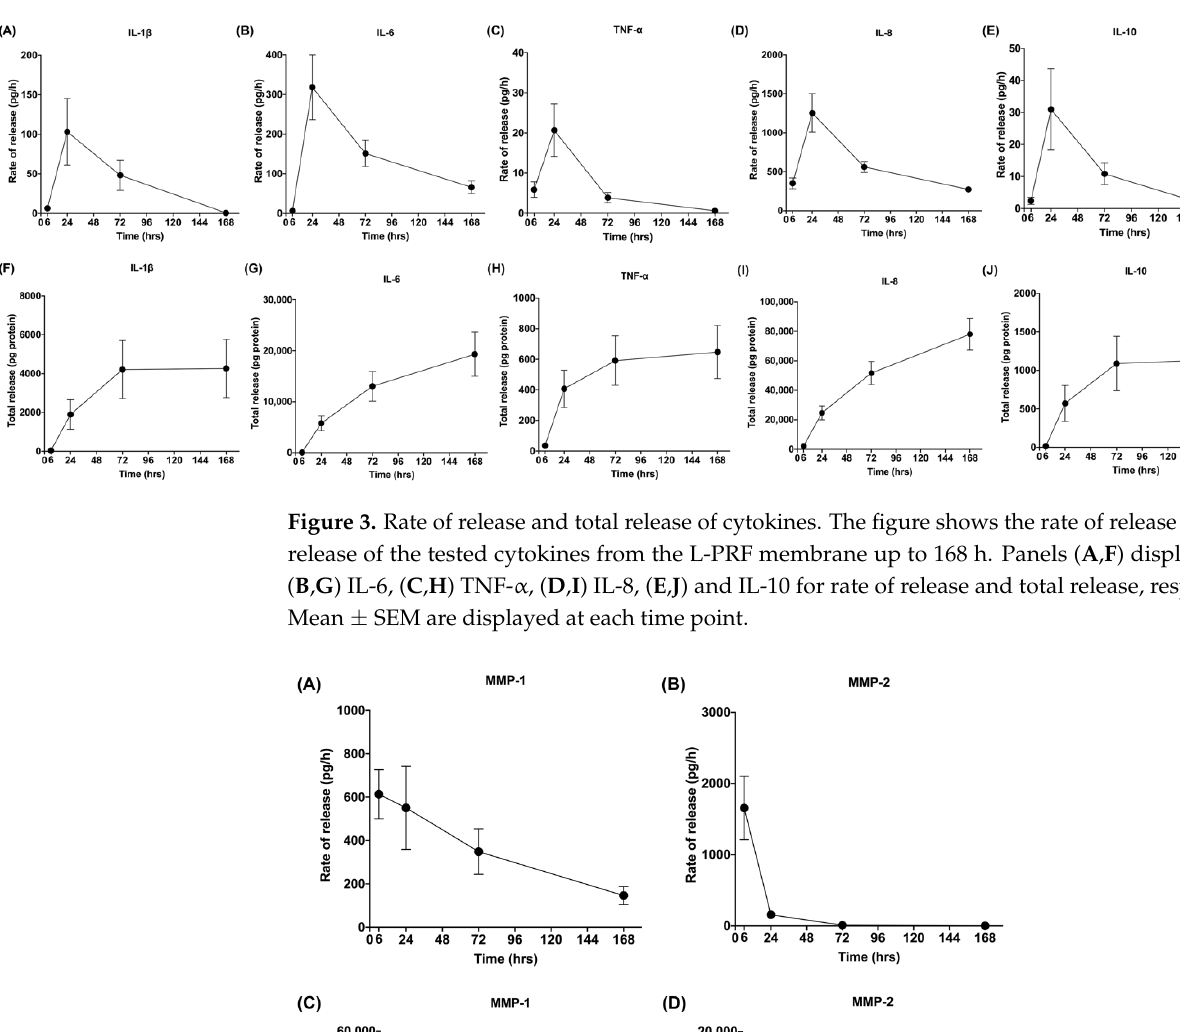
Figure 2. Rate of release and total release of GFs. The figure shows the rate of release and total release of the tested GFs from the L-PRF membrane up to 168 h. Panels ( A , E ) display TGF- β 1, ( B , F ) PDGF-AA, ( C , G ) PDGF-AB/BB, ( D , H ) FGF-2, ( I , L ) EGF, ( J , M ) VEGF, and ( K , N ) ANG-2 for rate of release and total release, respectively. Mean ± SEM is displayed at each time point.